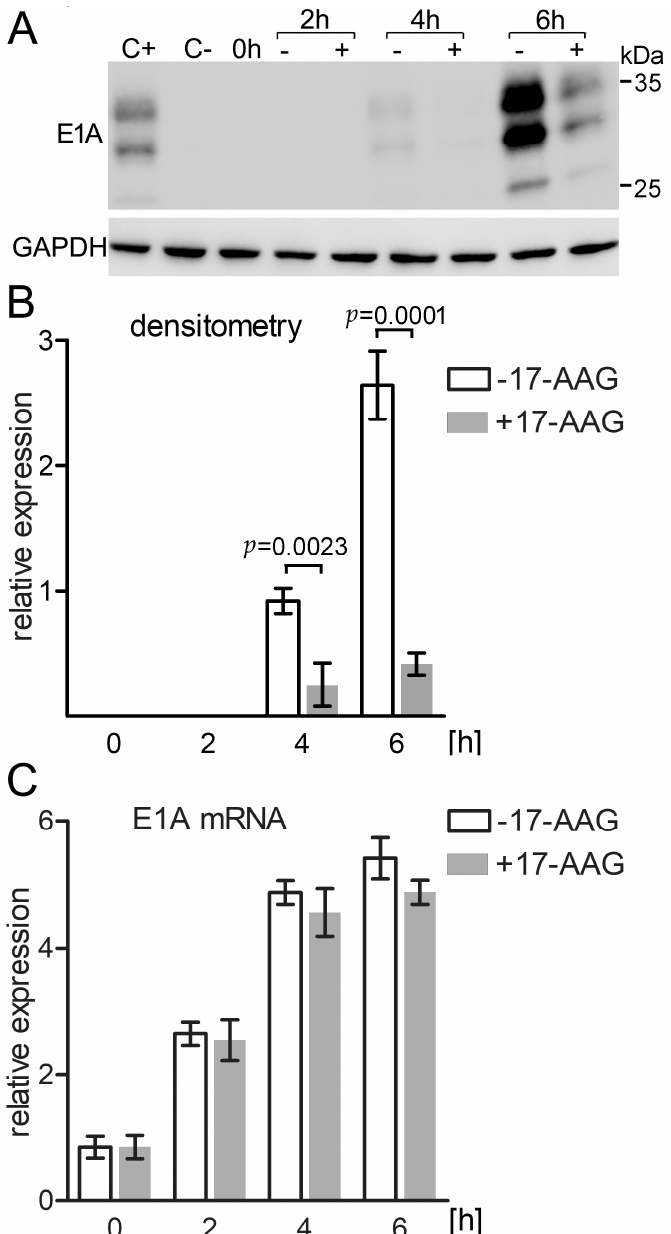
Figure 6. 17-AAG inhibits E1A translation, but not transcription. ( A ) A549 cells were infected with HAdV-5 at TCiD 50 5 ∙ 10 5 /mL for 15’ at 37 °C. After infection cells were washed 2 times with PBS and incubated in medium with 4 μ M 17-AAG (+), or without it (-) for the indicated time. C- and C+ represent protein extracts of not infected and infected cells, respectively. Western blot was probed with E1A specific antibody. ( B ) Densitometric quantification of the western blot results for E1A normalized to GAPDH. ( C ) q-PCR was used to measure content of the E1A mRNA. q-PCR results were normalized to the results obtained with GAPDH specific primers. Plots B and C represent means and SD from three independent